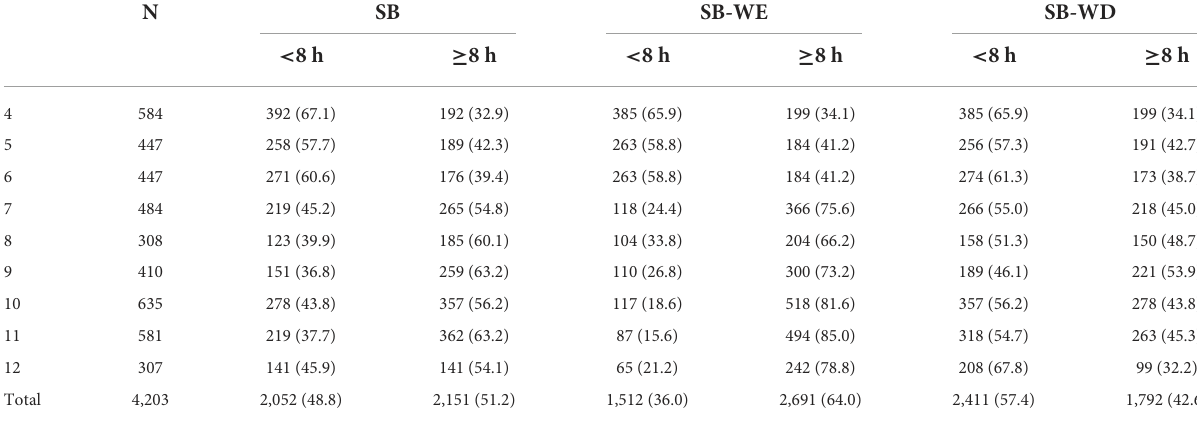
TABLE 8 Detection rate of high sedentary behavior in children and adolescents of different grades [N (%)].